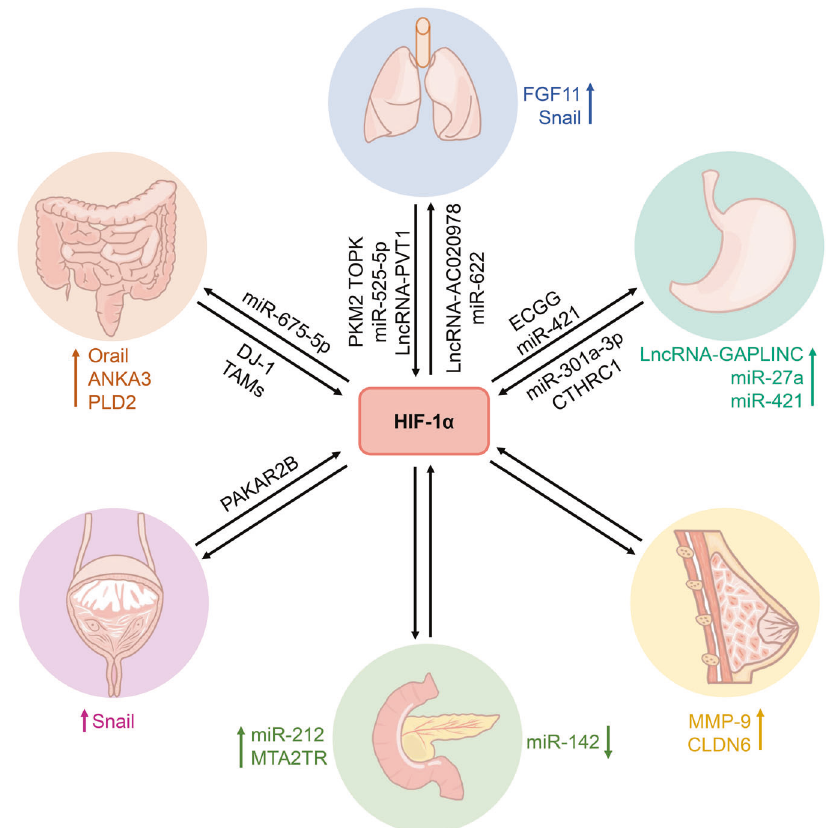
Fig. 5 Summarized paticipation of HIF-1 α in the tumorgenesis. The roles of HIF-1 α in various kinds of human cancer. The tumorgenesis arises by the regulation of HIF-1 α with intermediator and effectors such as indicated protein, miRNAs, or